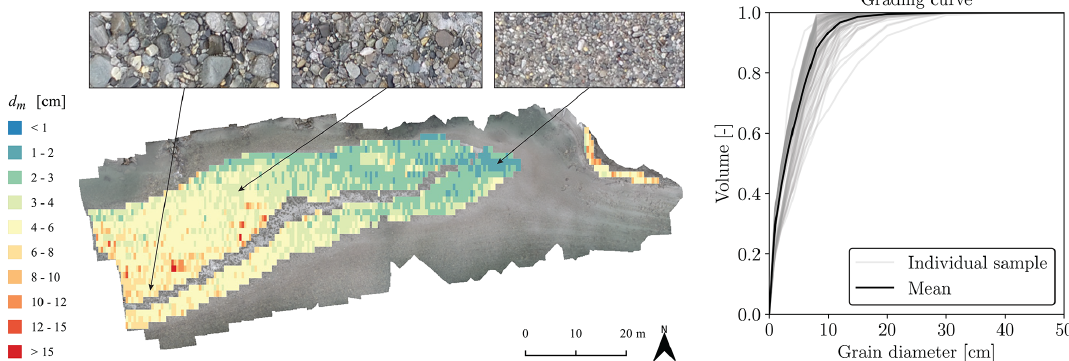
Figure 1. Illustration of the two final products generated with GRAINet on the river Rhone. Left: map of the spatial distribution of charac- teristic grain sizes (here d m ). Right: grading curve for the entire gravel bar population, by averaging the predicted curves of individual line